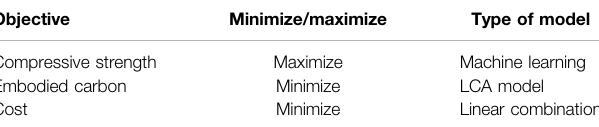
TABLE 2 | Objective